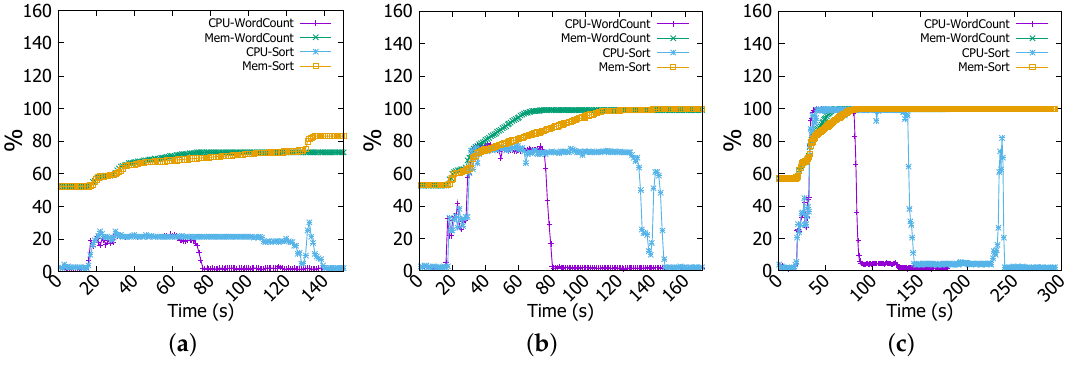
Figure 5. CPU and memory usage. ( a ) 1 GB file; ( b ) 4 GB file; ( c ) 6 GB